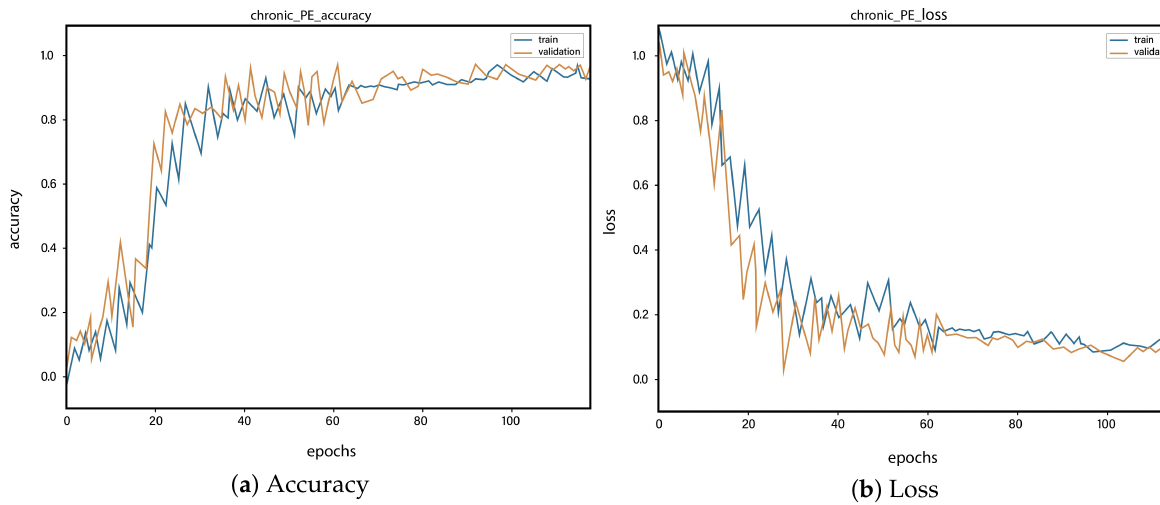
Figure 12. Training vs. validation accuracy and loss for the class: Indeterminate PE.